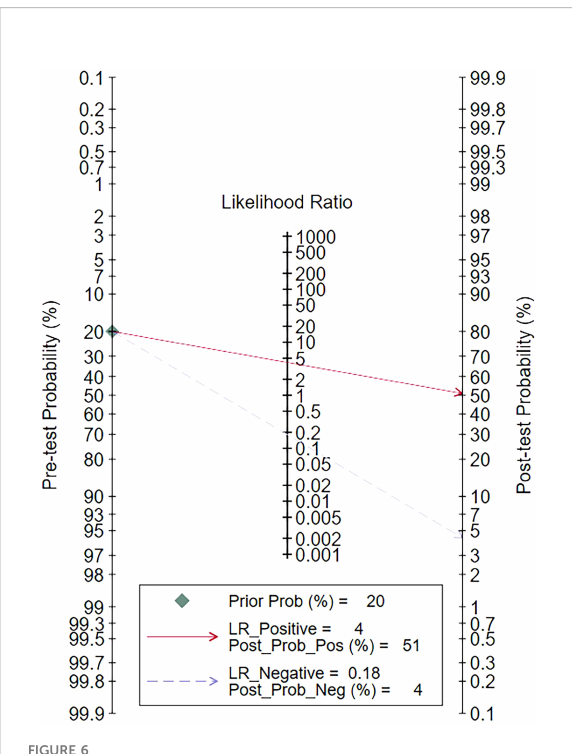
FIGURE 6 Fagan plots for assessing the clinical utility. LR, likelihood ratio; Prob, probability; Pos, positive; Neg,